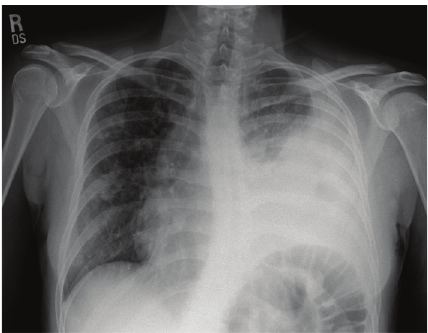
Figure 1: Chest radiograph showing left-sided pleural effusion shortly after admission.